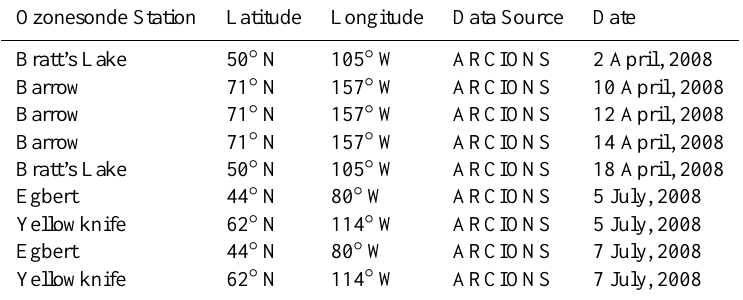
Table 2. Ozonesonde Station Locations and Data Providers for the 11 TES Coincidences used for V003 and V004 TES data comparisons